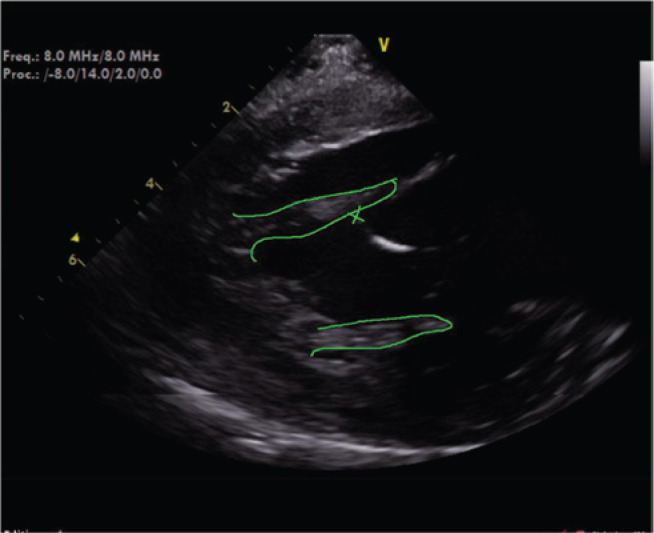
Intracardiac echocardiograph imaging demonstrating contact on the posteromedial papillary muscle.